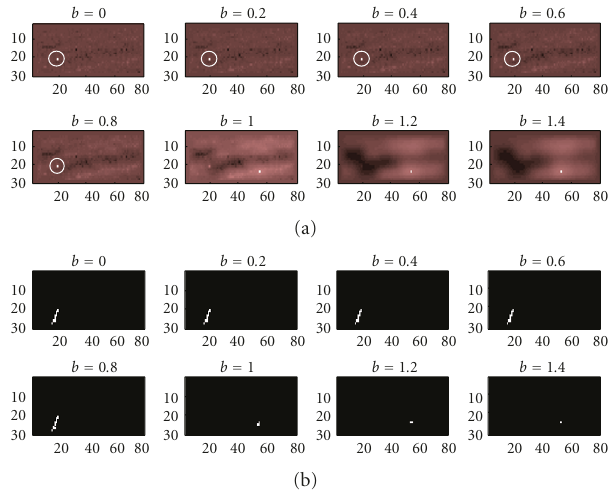
Figure 25: NPA sequence, s n = 3, g = 1 case. (a) The last frame of the algorithm, highest 5 pixels emphasized versus b (target pixel surrounded by a white circle), (b) the target track versus b .